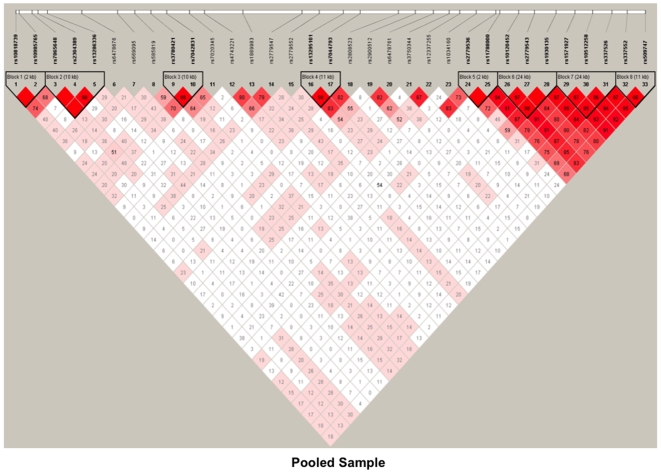
Linkage disequilibrium (LD) map of 33 SNPs within GABBR2 in pooled sample.Dark red denotes high LD (D′ = 1 and LOD >2). Lower LD values are represented in shades of pink (0.21<D′<1 and LOD >2). White represents low LD and low LOD (LOD <2). Numbers indicate the D′ statistic for two consecutive SNPs. LD blocks were defined using Haploview [25].